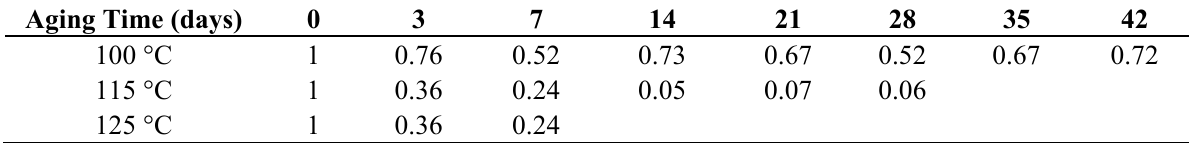
Table A9. Fracture strain of the nanolayered film with 4,094 layers of 31 nm thick (Type 4 film in Table 2) aged at temperatures of 100 °C, 115 °C and 125 °C. The data were normalized by the pristine material